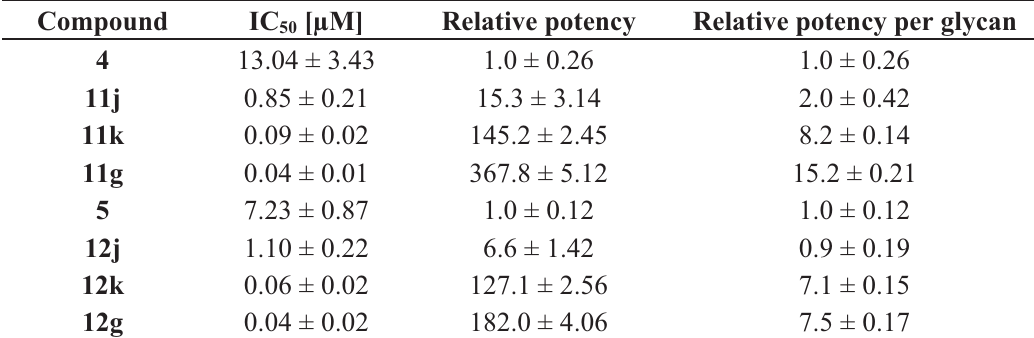
Figure 7. IC 50 values of soluble tetrasaccharides and neo-glycoproteins. IC 50 values of neo-glycoproteins 11j , 11k , 11g , 12j , 12k and 12g ((cid:4)) are compared with those of free tetrasaccharides 4 and 5 ((cid:4)) for 5 μM galectin-3 binding on ASF. Lower values indicate higher inhibitory potencies. IC 50 values in [μM] were calculated using Sigma Plot software. Table 3. Inhibition and relative potencies of galectin-3 binding to ASF by soluble tetrasaccharides and neo-glycoproteins. Relative potencies are related to the corresponding tetrasaccharide and additionally to one binding site. Neo-glycoproteins show up to 15 times enhanced potencies per glycan compared to soluble